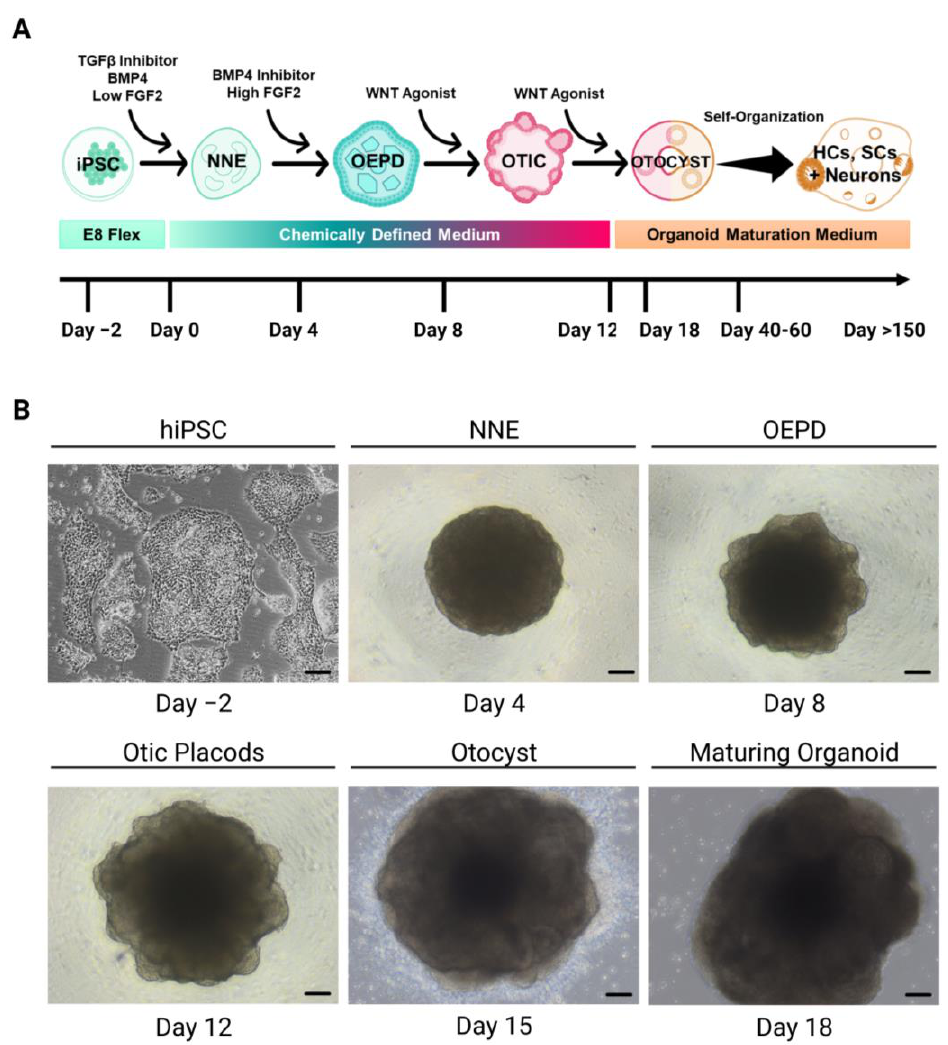
Figure 4. Generation of inner ear organoids from hPSCs (modified from Nie and Hashino 2020 [109]). ( A ). 3D differentiation protocol of hPSCs into inner ear organoids from Koehler et al. [17]. ( B ). Images of inner ear organoids generation. NNE: Non-neural ectoderm. OEDP: Otic-epibranchial progenitor domain. OTIC: Otic Placodes. (Created with BioRender.com, accessed on 22 March 2023).